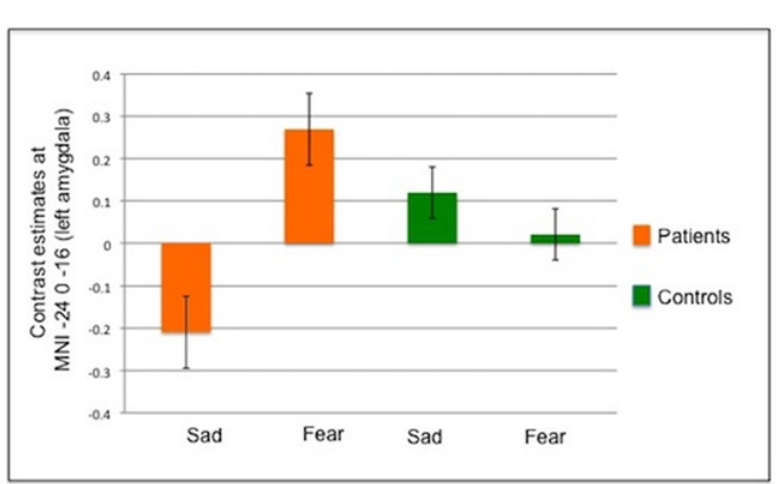
Fig 2. ROI analysis: Interaction effect in the Linear-change Model. Graph showing group-level beta estimates for the linear change in the responsiveness of the left amygdala to the presentation of emotional stimuli. Here a positive beta indicates a linear increase in the magnitude of the response elicited by stimuli following repeated exposure. Negative betas indicate the response amplitude reduced over time (see S1 Fig for a graphical representation of the predicted BOLD time series scaled by these group beta